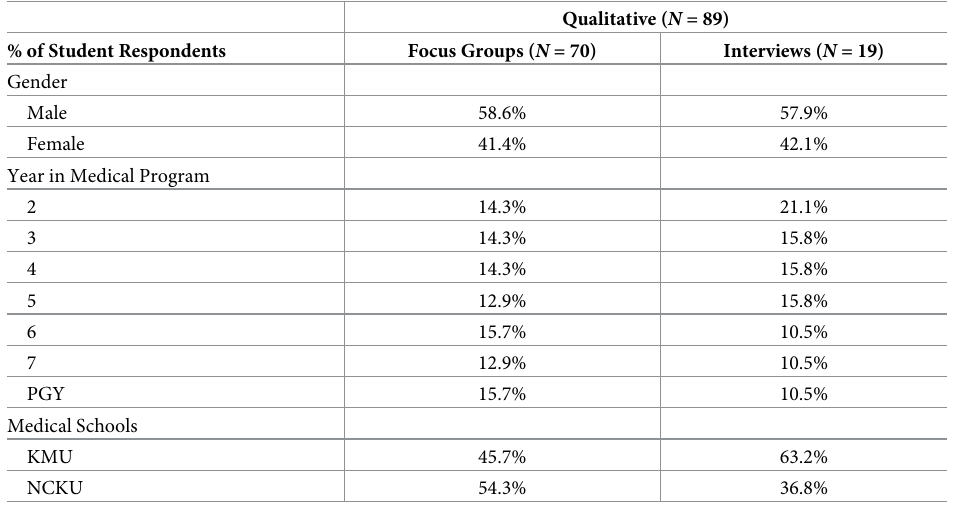
Table 2. Demographics of student participants from two medical schools in Taiwan: 2015–2017.